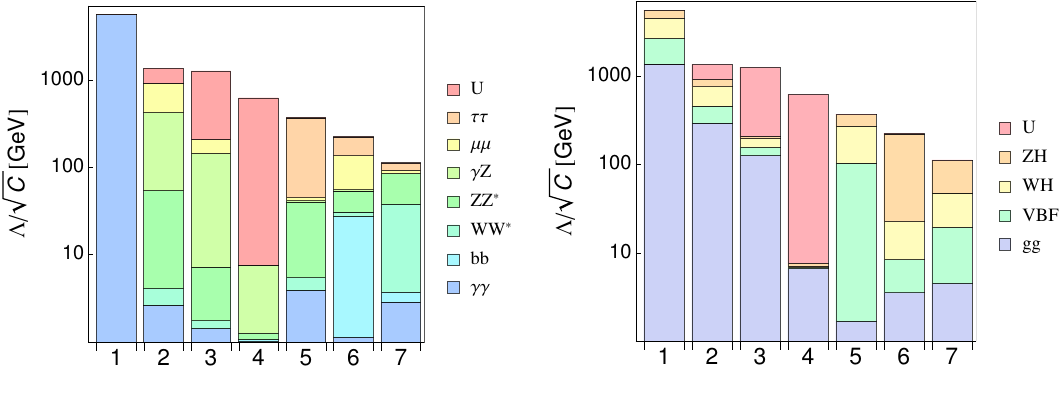
Figure 2 . Sensitivities for each eigenstate, and the relative contributions from each channel for (cid:22) EFT = 125 GeV.